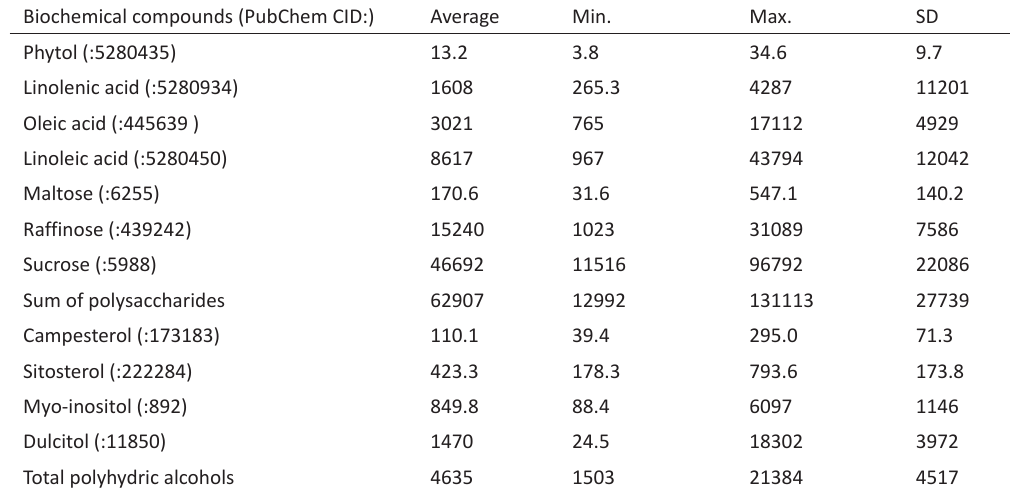
Table 2. The content of phytol, polyunsaturated fatty acids, polysaccharides and polyhydric alcohols in seeds of hemp ( Cannabis spp.) accessions (ppm in dry matter ), NW of Russia, 2017‒2018* Biochemical compounds (PubChem CID:) Average